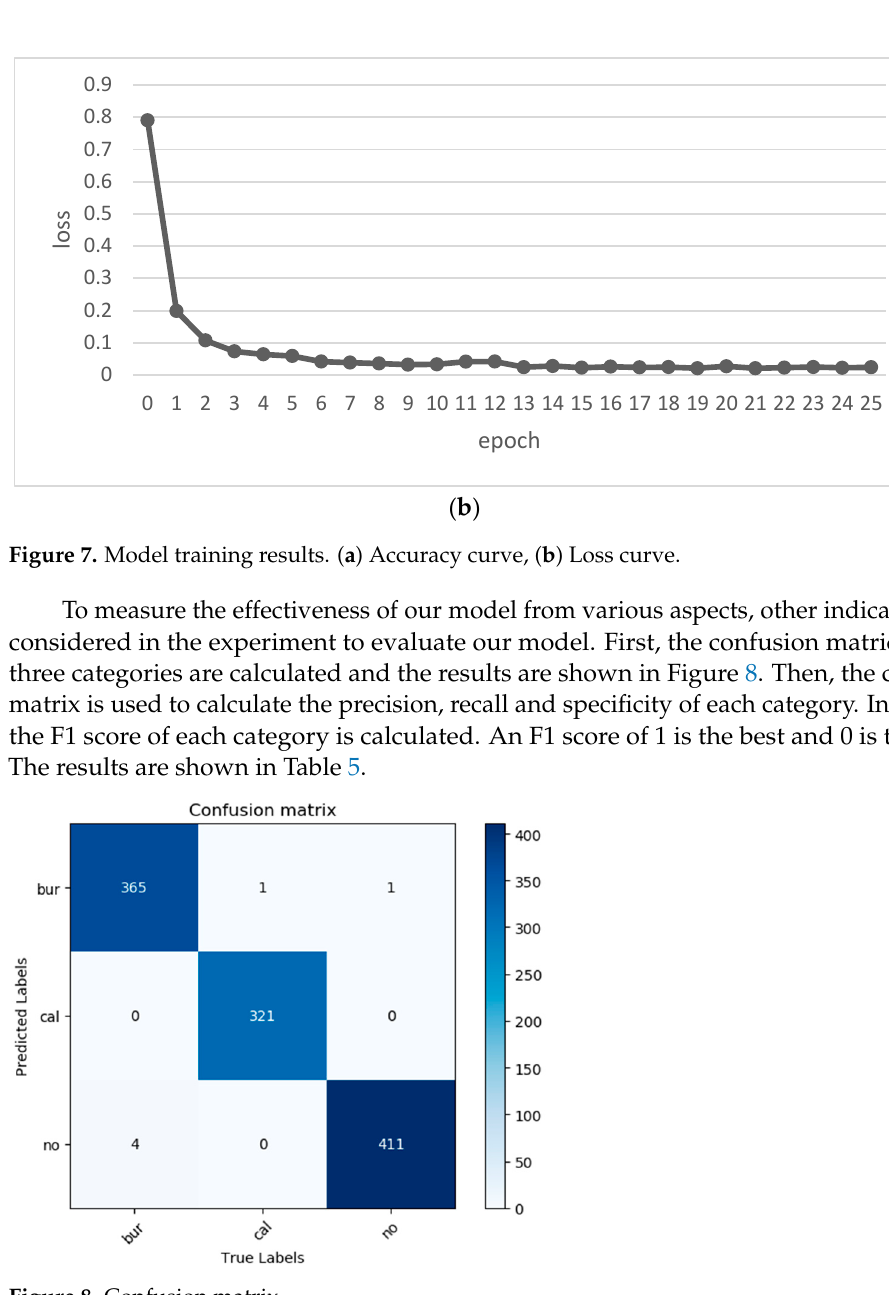
Figure 8. Confusion matrix. Table 5. Experimental results of our